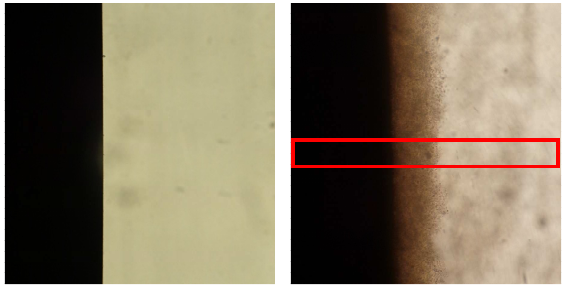
Fig. 4. Images from the digital camera of the clean hollow fiber membrane and after 1 hour of filtration (10x magnification lens).